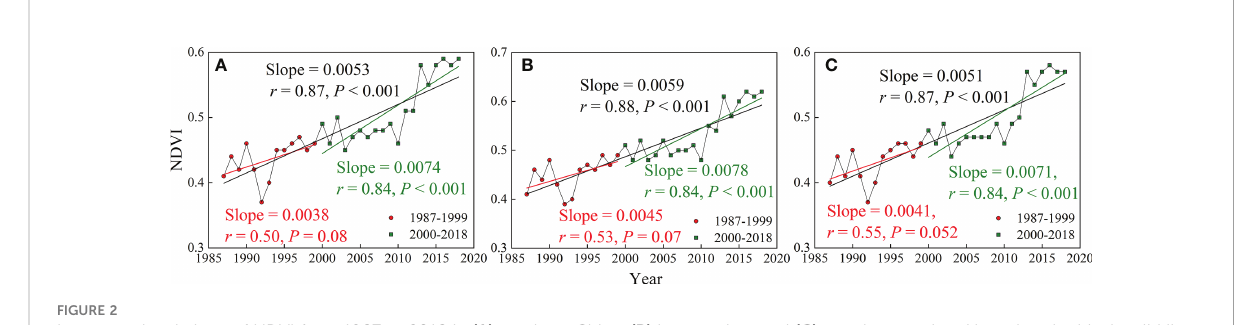
FIGURE 2 Interannual variations of NDVI from 1987 to 2018 in (A) southern China, (B) karst region, and (C) non-karst region. Note that the black solid line is the linear fi tting of NDVI for the full time series (1987-2018), while the red and green solid line denote the linear fi tting of NDVI for the reference period (1987-1999) and conservation period (2000-2018),